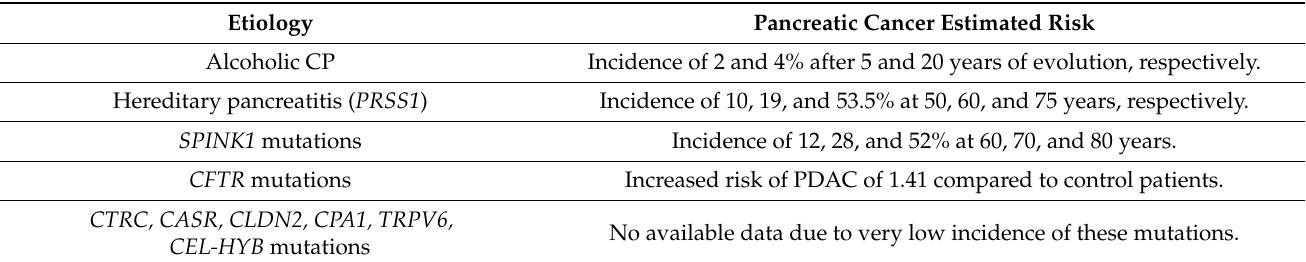
Table 2. Pancreatic cancer risk according to the etiology of chronic pancreatitis. Etiology Pancreatic Cancer Estimated Risk Alcoholic CP Incidence of 2 and 4% after 5 and 20 years of evolution, respectively. Hereditary pancreatitis ( PRSS1 ) Incidence of 10, 19, and 53.5% at 50, 60, and 75 years, respectively. SPINK1 mutations Incidence of 12, 28, and 52% at 60, 70, and 80 years. CFTR mutations Increased risk of PDAC of 1.41 compared to control patients. CTRC, CASR, CLDN2, CPA1, TRPV6, No available data due to very low incidence of these CEL-HYB mutations